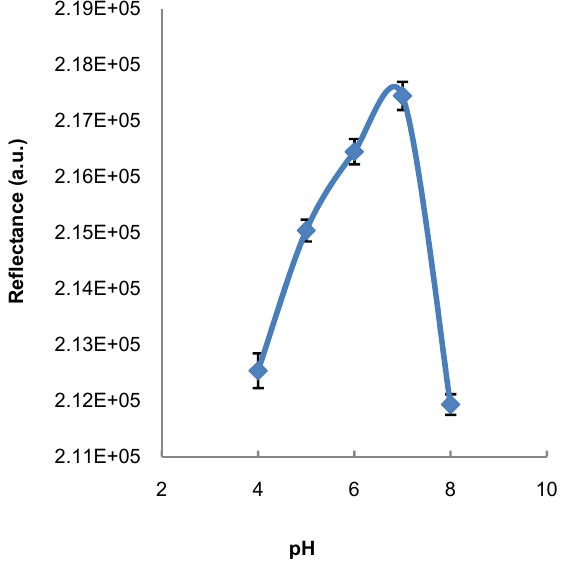
Figure 2. The effect of pH on the detection of benzoic acid (100 ppm) using the developed test